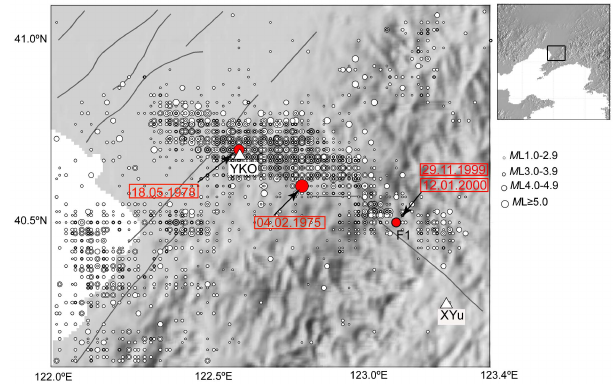
Fig. 1. Earthquakes with M L ≥ 1.0 recorded by the Liaoning Province Seismograph Network since 1970. Red dots show the 4 earthquakes with M s ≥ 5.0 within this time period, including the 1975 Haicheng M s =7.3 earthquake, the 1978 Yingkou M s =5.9 earthquake, the 1999 Xiuyan M s =5.4 earthquake, and the 2000 Xiuyan M s =5.1 earthquake. Grid-like distribution of epicenters reflects the limitation of the location capability. For earthquakes larger than M s = 7.0, the epicenter reflects the initiation point of the earthquake rupture. The 1975 Haicheng earthquake ruptured 54km striking N70 ◦ W, with dip angle 81 ◦ dipping NE. Tectonic faults are shown by dark gray lines, in which the NW striking fault (F1) is the Haicheng River-Dayang River fault causing the 4 earth- quakes above M s 5.0. Location of the Xiuyan (XYu) station and the Yingkou (YKo) station are also shown in the figure by white